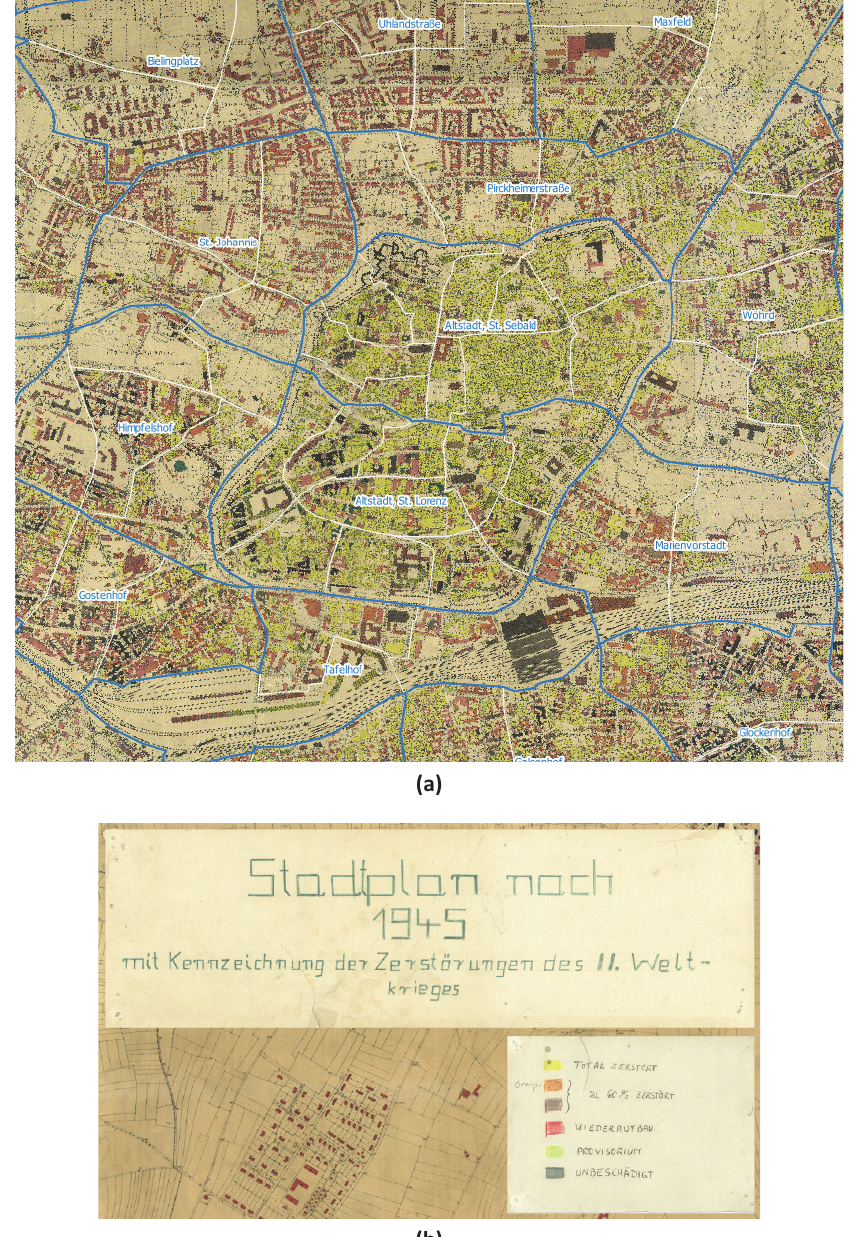
Figure 2. (a) The damage map of Nuremberg (1950, detail) with superimposed district boundaries (in white) for city quar‐ ters (in blue). (b) The map legend shows the five levels from completely damaged to intact buildings. Source: